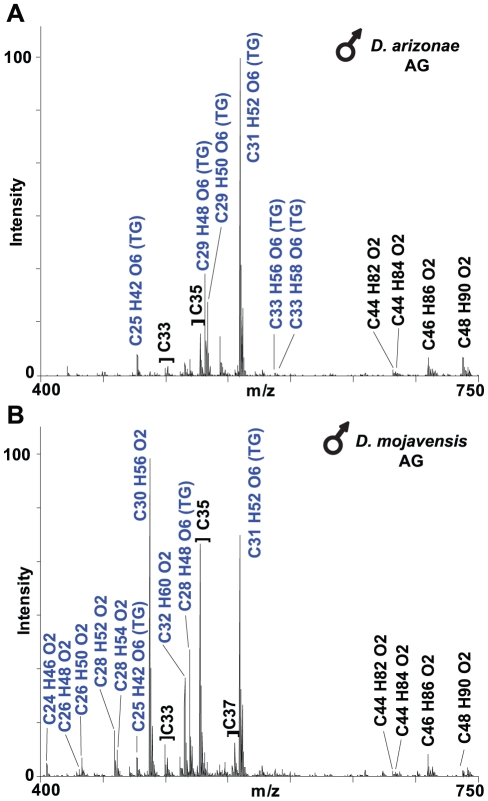
Representative mass spectra from male D. arizonae (A) and D. mojavensis (B).UV-LDI MS analysis reveals profile differences in CHCs and putative triacylglycerides (TG) that are specific to the anogenital region (AG). Each compound is labeled with the predicted elemental composition. Compounds found only in the AG are labeled in blue.